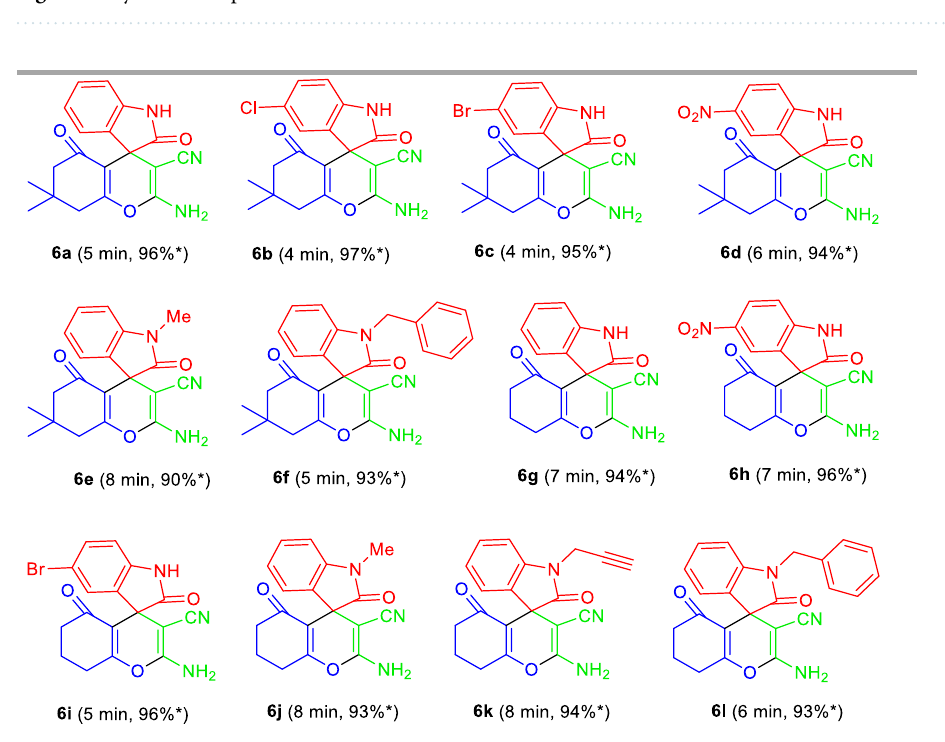
Table 3. Substrate scopes for the synthesis of 2-amino-tetrahydrospiro[chromenes-3,4 ′ -indoline]- 3-carbonitriles 6a-l . Reaction condition: Isatins 5a–g (1.0 mmol), malononitrile 2 (1.0 mmol), and 5,5-dimethylcyclohexane-1,3-dione 3a /cyclohexane-1,3-dione 3b (1.0 mmol) in the presence of 10 mol% of